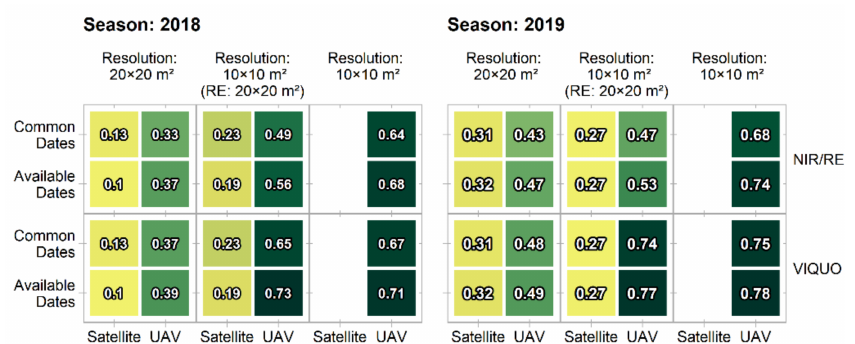
Figure 5. R 2 -values of the linear regressions between the total absorbed effective photosynthetic radiation and the final grain yield. Differences arise upon the modified UAV and satellite data basis (Table